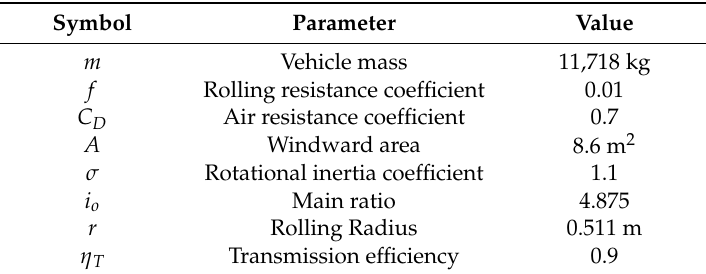
Table 2. E-REB model